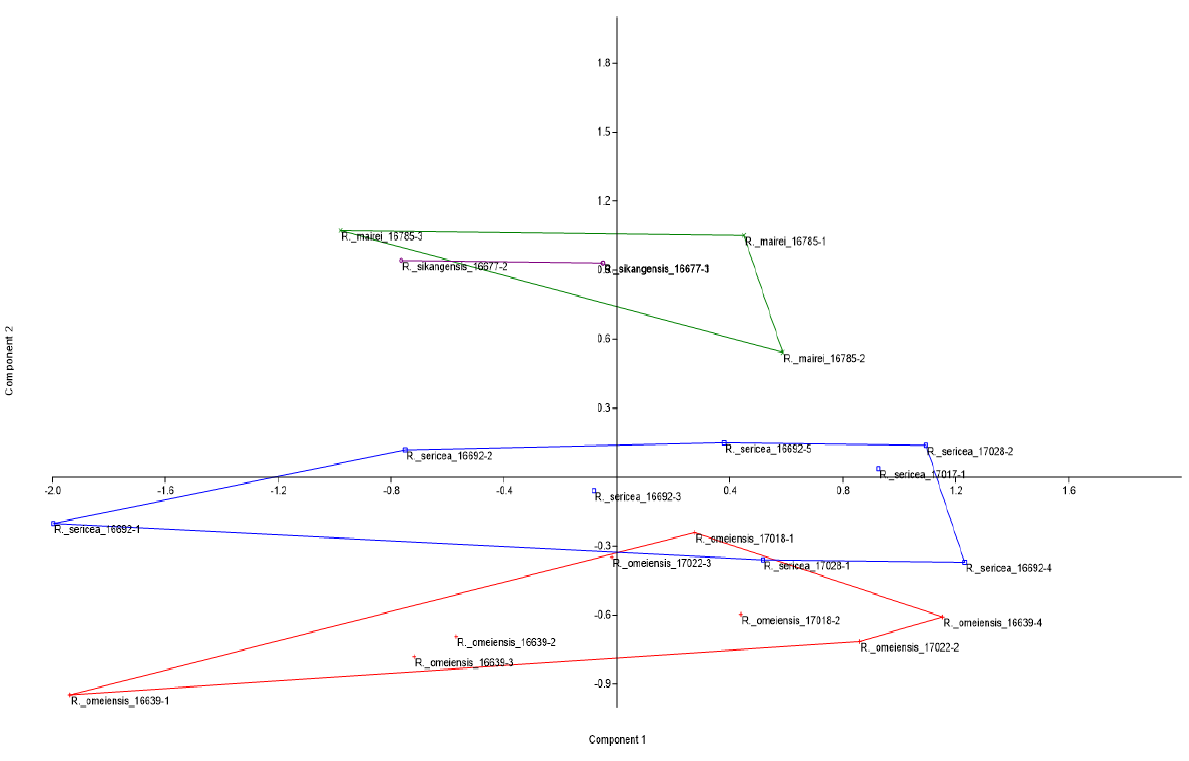
Figure 7. PCA analysis of pollen morphological characteristics in different populations.